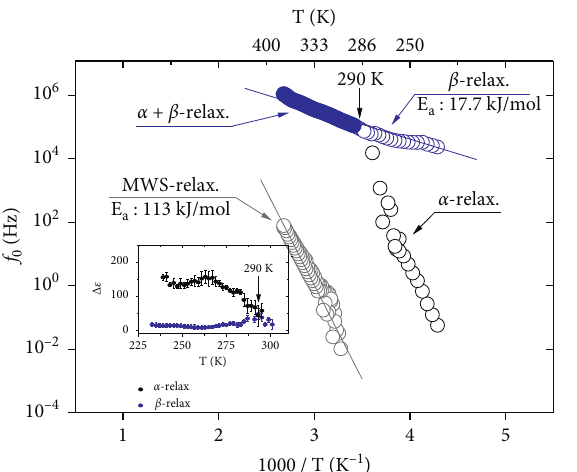
Figure 14: The relaxation rate versus reciprocal temperature for EPDM. The activation energy for the relaxation process was the slope of the solid line. The overlapped circle symbols of MWS and α -relaxation just denote the repeated analysis. The inset shows the variation in relaxation